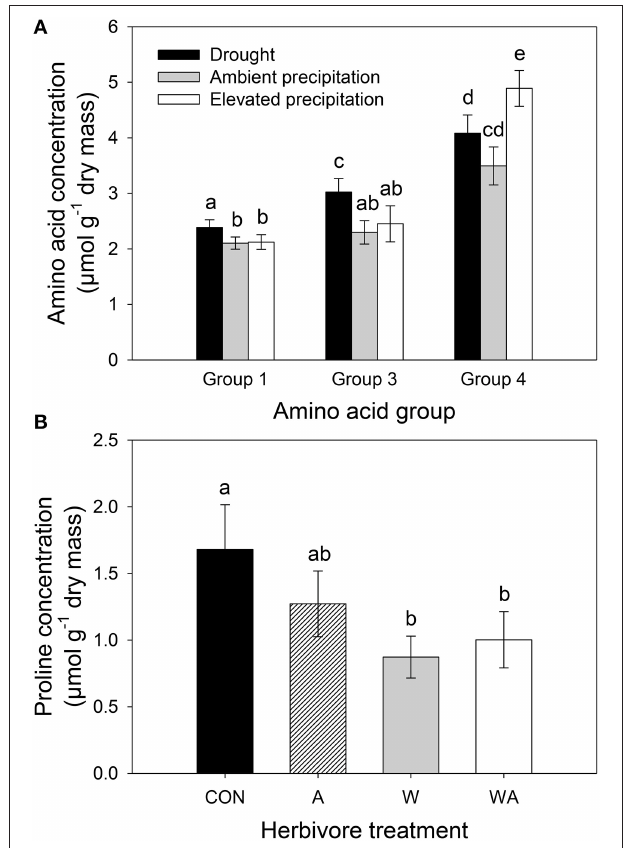
FIGURE 7 | The impacts of precipitation on individual groups of amino acids (A), namely group one (glycine, lysine, methionine, tyrosine, cysteine, histidine, arginine), group three (aspartate and glutamate), and group four (glutamine and serine) and the impacts of herbivore treatment on proline concentrations (B). CON were the control plants (no insects), A had aphids alone, W had weevils alone, and WA had both insects. Mean values ( ± SE) are shown. Bars with the same letters were not significantly different ( P < 0.05).